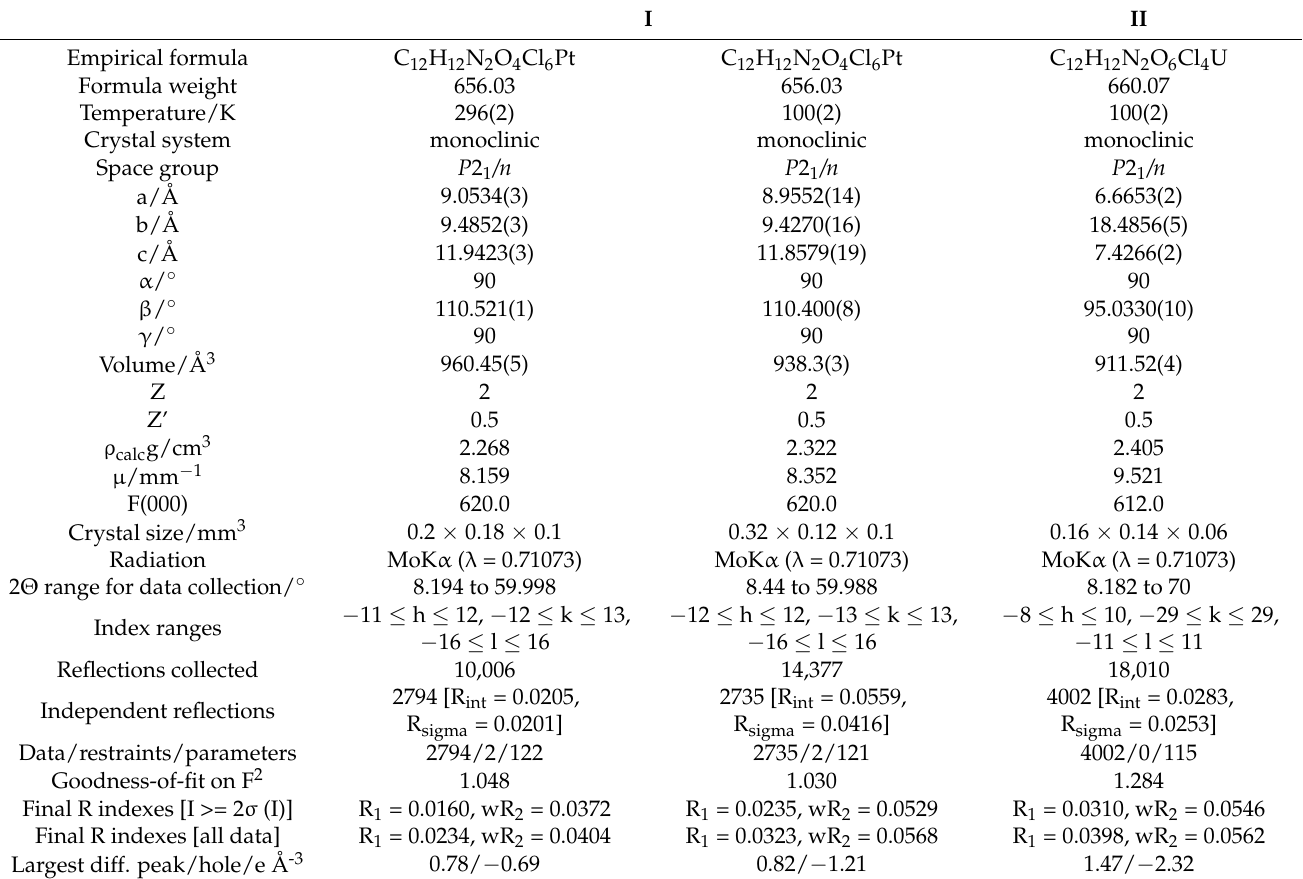
Table 1. Crystal data and structure refinement for structures I and II .